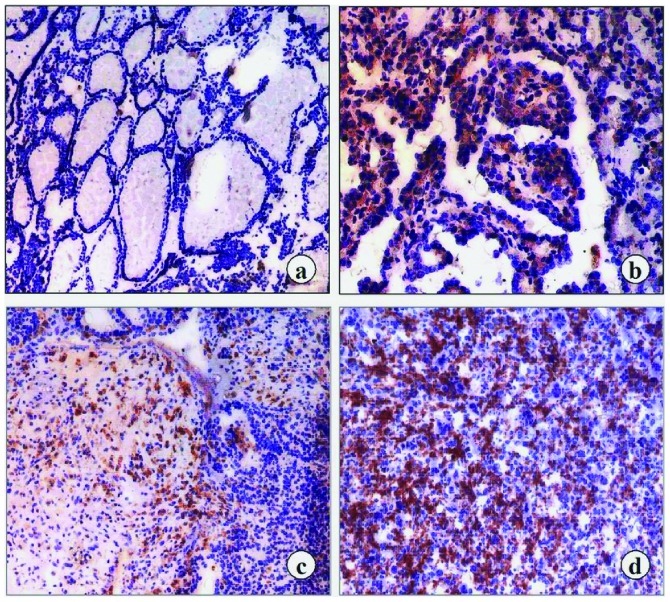
Immunostaining patterns of survivin in frozen human thyroid tissue samples. (a) Thyroid goiter tissue with a loss of expression of survivin. (b) Strong immunostaining in a primary PTC (pT4N0M0). (c) A primary FTC (pT4N1M0) showing moderate survivin protein expression. (d) Uniformly intense staining of survivin protein expression in UTC (pT4N1M0) tissue. PTC, papillary thyroid cancer; FTC, follicular thyroid cancer; UTC, undifferentiated thyroid cancer.